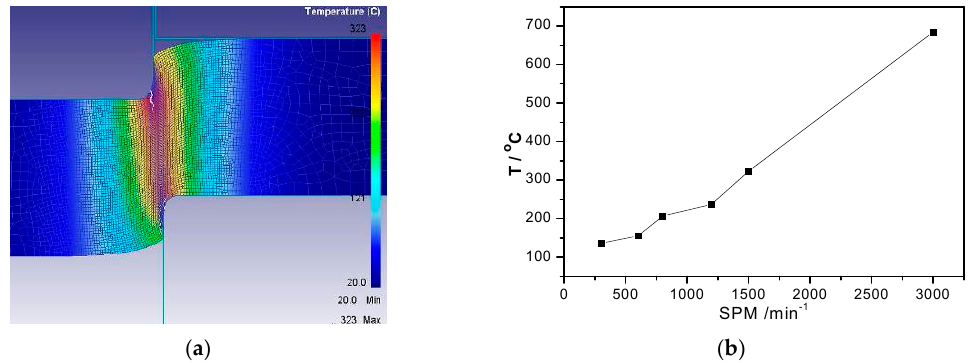
Figure 5. FEM-simulated temperature distribution of the blanked edge at different blanking speeds. ( a ) Temperature distribution of blanked surface 1500 strokes per minute (SPM 1500); ( b ) Relation curve between temperature distribution of blanked surface and blanking speed.